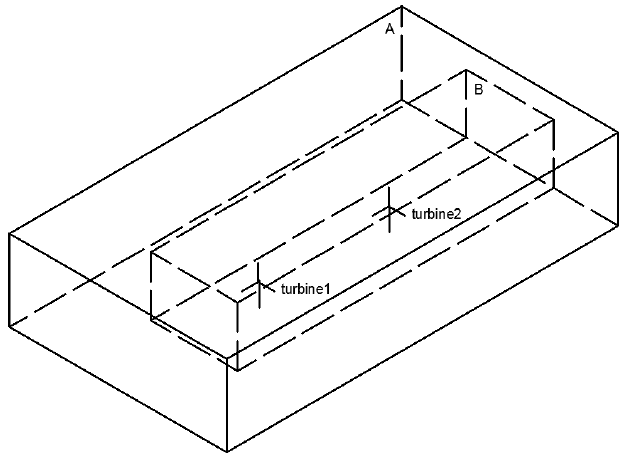
Figure 6. The simulation domain of single wind turbine.